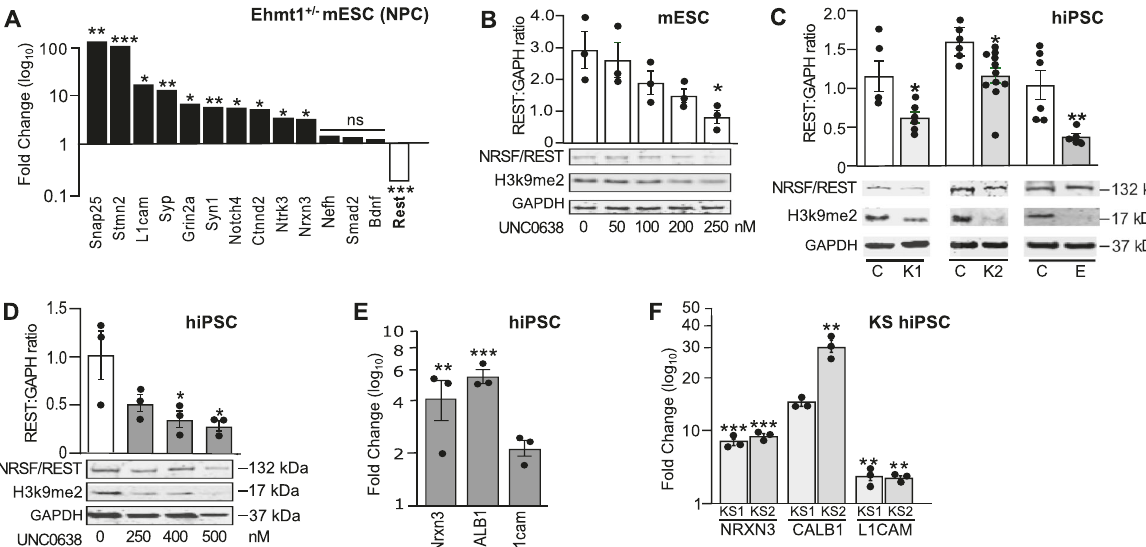
Fig. 1 Expression of NRSF/REST and its target-genes in reduced EHMT1 activity and KS patient iPSC. A Gene analysis using qRT-PCR of Ehmt1 − / + mESC-derived NPCs compared to wild type cells. Expression of NRSF/REST mRNA was decreased while neuronal genes regulated by REST were elevated in Ehmt1 − / + cells. Mean fold change over wild type NPCs, n ≥ 3 independent experiments, log 10 scale axis. B – D Western blot analysis of NRSF/REST and H3K9me2 protein in pluripotent cells: ( B ) mESC following treatment with range of UNC0638 concentrations for 48 h; ( C ) KS patient (2 patients; KS1 and KS2) and EHMT1 − / + iPSC (denoted as E ) compared to the isogenic control hiPSC; ( D ) Nonpatient control iPSC treatment with range of UNC0638 concentrations for 72 h. Plotted as Western band intensity normalized to GAPDH, n ≥ 3. E , F Expression of REST-target genes NRXN3, Calbindin (CALB1) and L1Cam in pluripotent hiPSC, measured by qRT-PCR: ( E ) control hiPSC treated with 250 nM UNC0636 for 72 h ( E ), and ( F ) pluripotent KS patient iPSC. Mean Fold change greater than untreated control hiPSC (log 10 axis), n ≥ 3 independent experiments. Data were presented as Mean±SEM and analysed by student ’ s t-test or One-way ANOVA with post hoc comparisons using Dunnett ’ s multiple comparisons test comparing to control samples. * P < 0.05, ** P < 0.01, *** P <